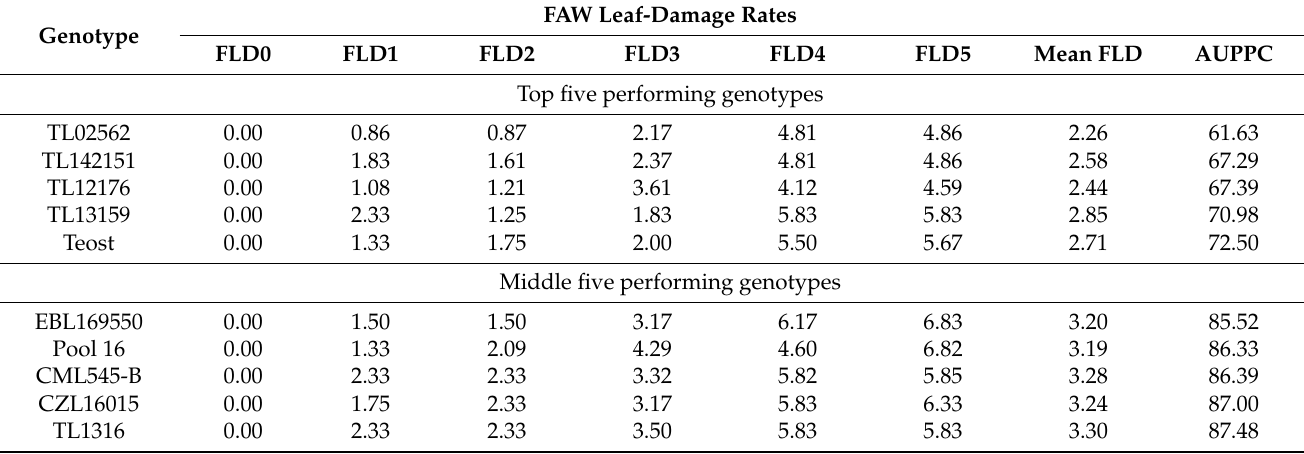
Table 7. Analysis of variance for FAW leaf damage among 63 genotypes evaluated under artificial FAW infestation in the screenhouse. Table 8. Mean performance of the top, middle and bottom five maize genotypes based on lowa damage